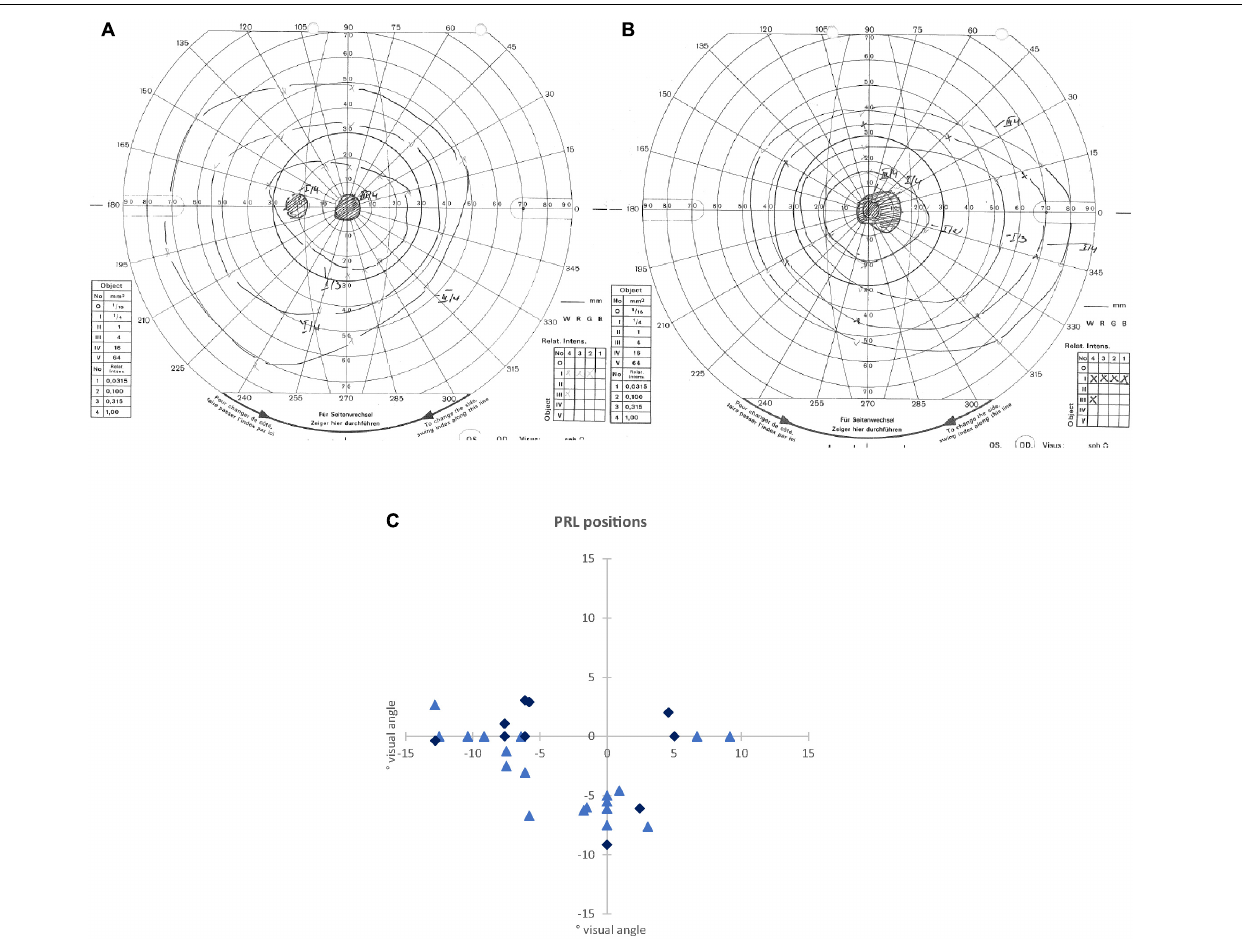
FIGURE 1 | (A,B) Examples of visual field measurements using Goldmann perimetry: (A) for the left eye of an AMD patient (P24), where scotoma borders of isopters III/4e and I/4e were identical. (B) For the right eye of a JMD patient (P11), where different scotoma borders resulted from isopters III/4e and I/4e. In this patient, the blind spot could not be detected independently of the scotoma from isopter I/4e. (C) Schematic depiction of the positions of the preferred retinal loci (PRLs) in visual field of each of the 32 patients (some PRL positions overlapping with each other). The PRL positions of the JMD patients are marked with light blue triangles, the PRL positions of the AMD patients are marked with dark blue